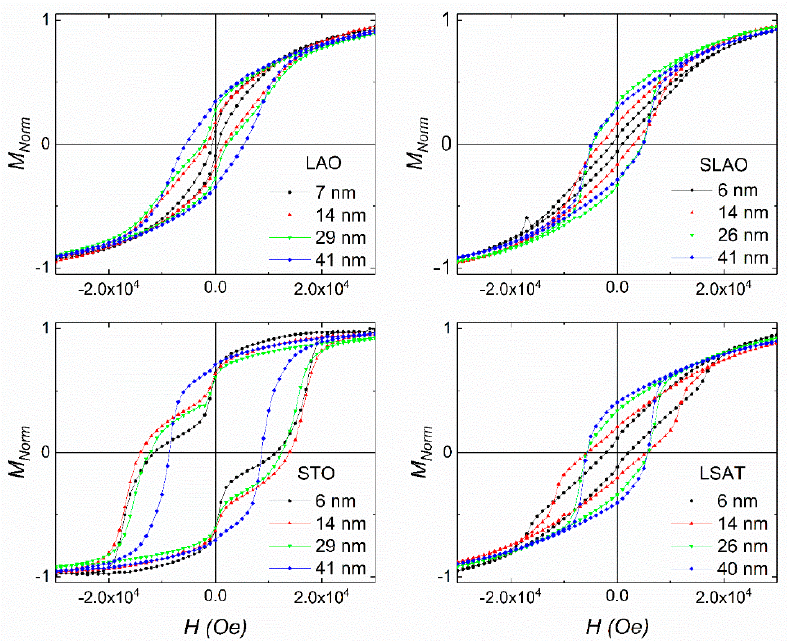
Figure 7. Normalized in-plane hysteresis loops performed at 5 K on LSCO films grown on LAO, SLAO, STO, and LSAT substrates.